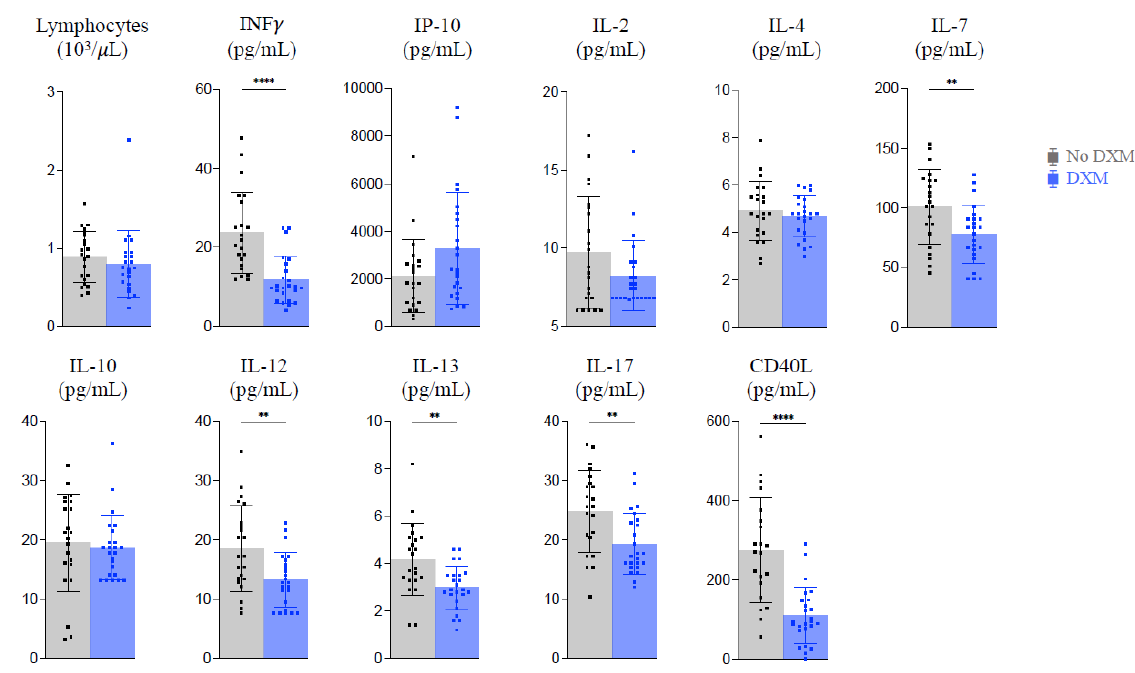
Figure 5. Corticosteroid effects on lymphoid immune response in critical COVID-19 patients. Scatter graphs of lymphoid inflammatory cytokines. Individual values (dots), mean (colored rectangle), and standard deviation are presented on the graphs. ** p < 0.01, **** p < 0.0001 between the no DXM group and the DXM group. CD40L, CD40 ligand; IFN γ , interferon gamma; IL, interleukin; IP-10, interferon gamma-induced protein 10.